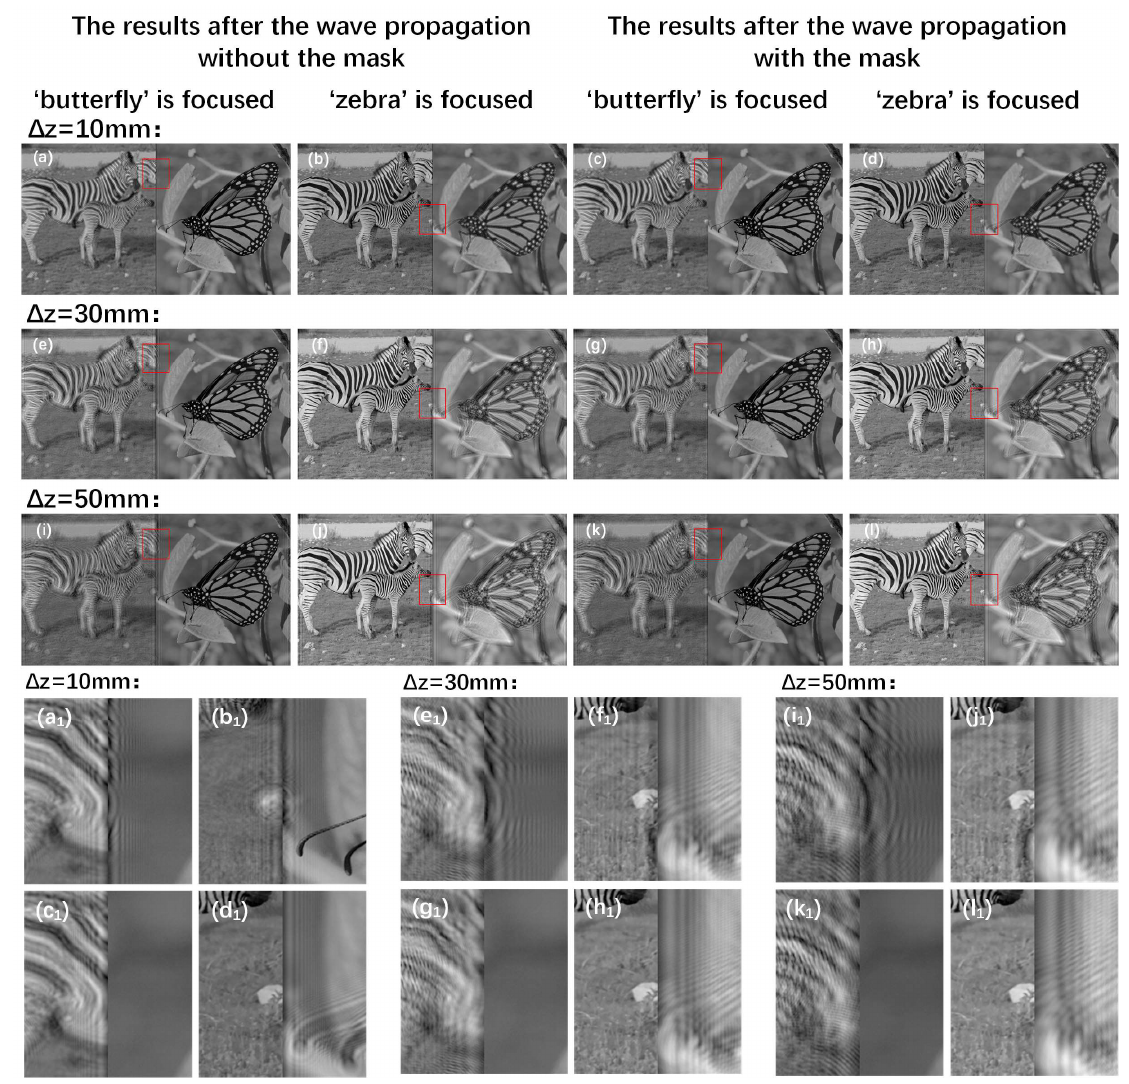
Figure 3. ( a , b ), ( e , f ), and ( i , j ) are the results after propagation without the mask when the distance Δz is 10 mm, 30 mm, and 50 mm, respectively. ( c , d ), ( g , h ), and ( k , l ) are the results after propagation with the mask. ( a 1 – d 1 ), ( e 1 – h 1 ), and ( i 1 – l 1 ) are the details of ( a – d ), ( e – h ), and ( i – l ) in the red box.